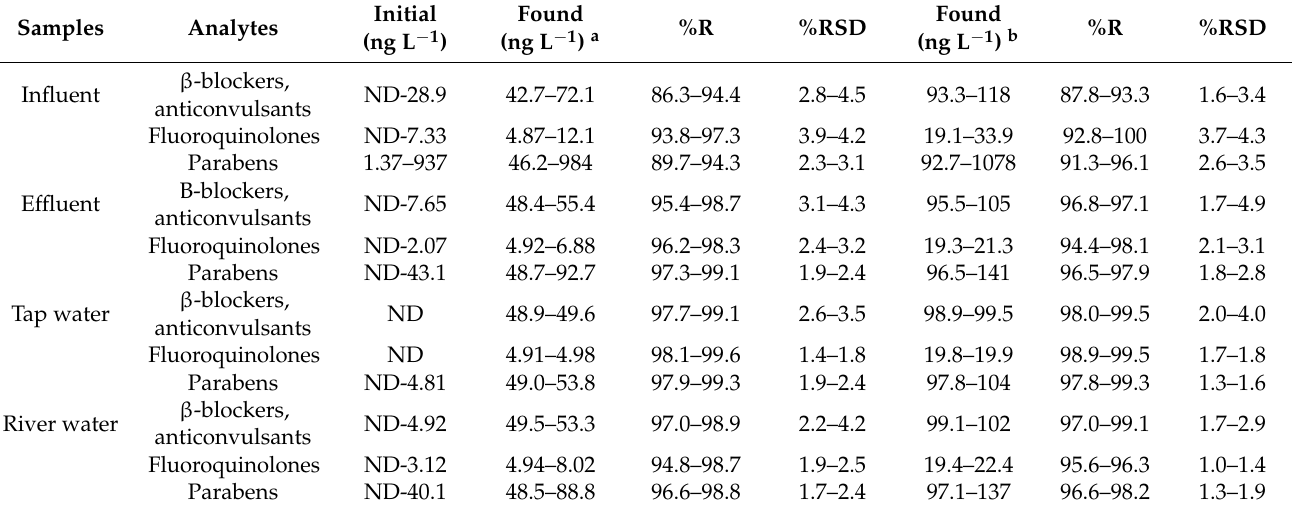
Table 4. Determination of β -blockers and anticonvulsants, fluoroquinolones and parabens in real water samples ( n = 3). Samples